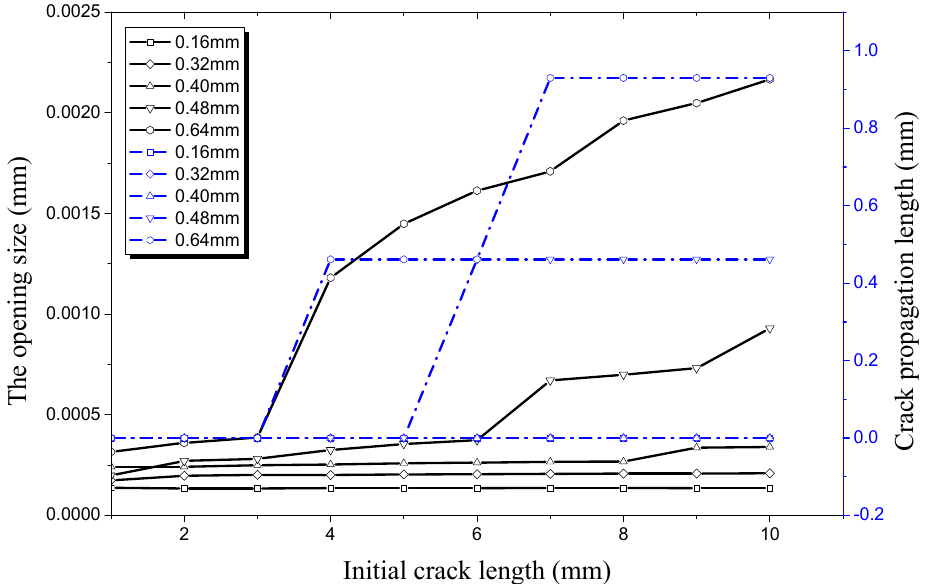
Figure 20. Relationship between longitudinal crack propagation length and initial crack length on the inner surface, along relationship between longitudinal opening size and initial crack length on the inner surface, both under an internal pressure of 21 MPa.